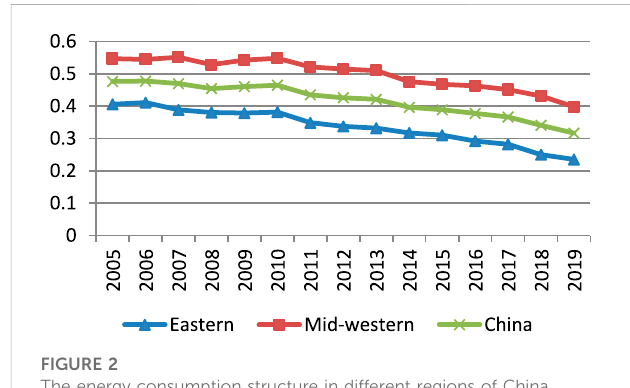
FIGURE 2 The energy consumption structure in different regions of